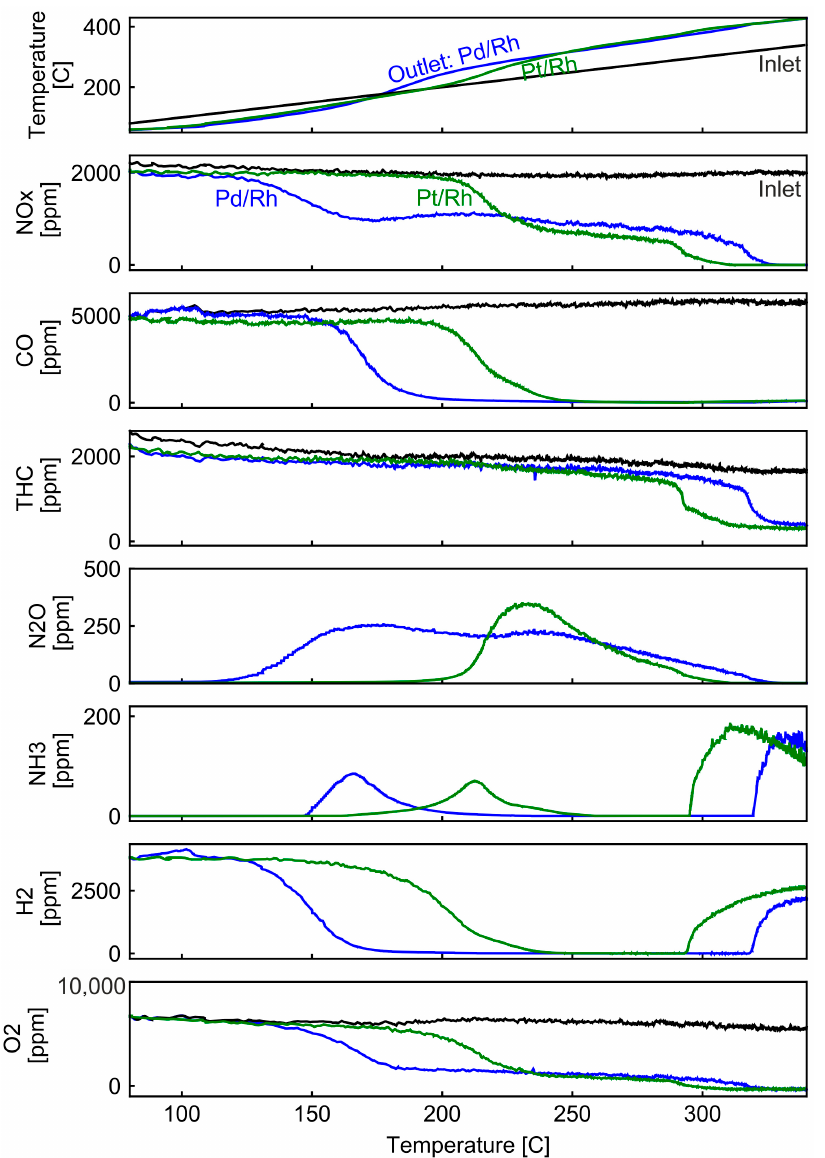
Figure 8. Comparison of temperature and concentration profiles upstream and downstream the Pd/Rh and Pt/Rh catalysts during cold start experiment.